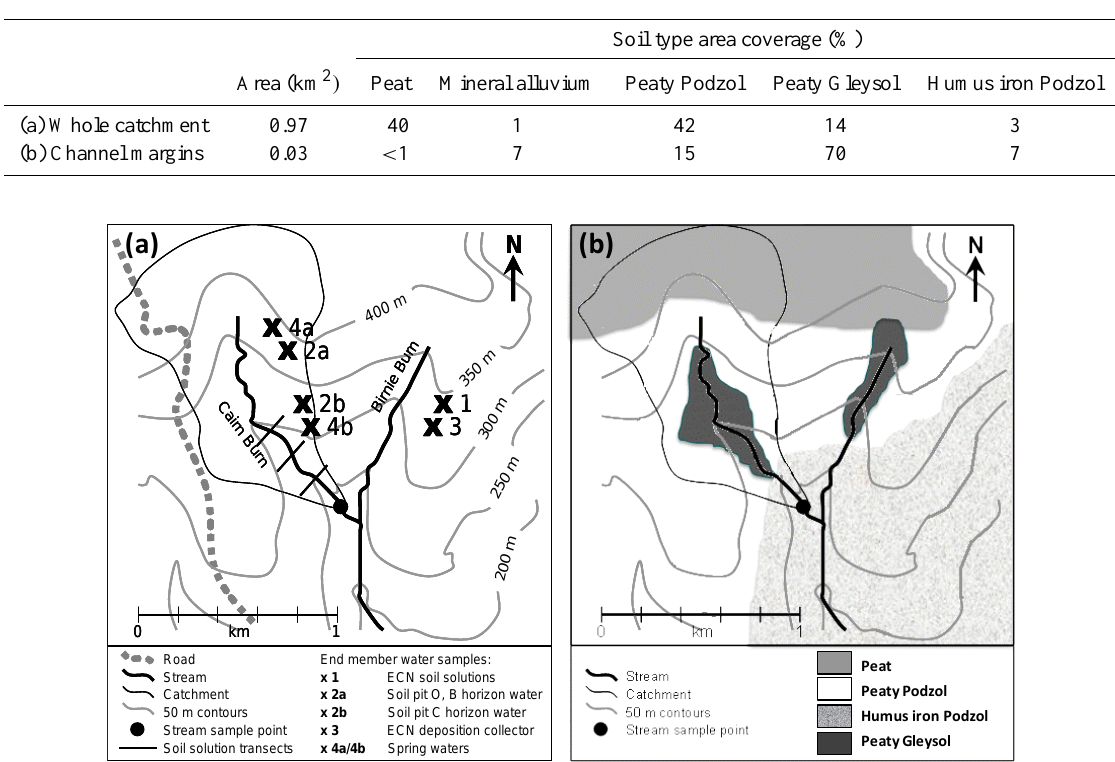
Fig. 1. (a) Catchment location, drainage network, stream and source water sample locations and (b) soil distribution.